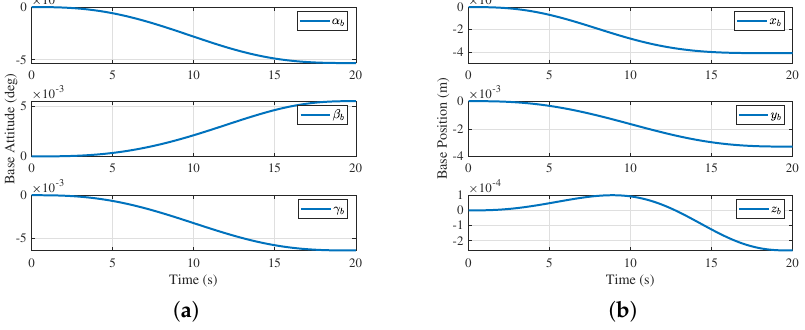
Figure 12. Pose variation of UAV base, where ( a ) UAV attitude, and ( b ) UAV